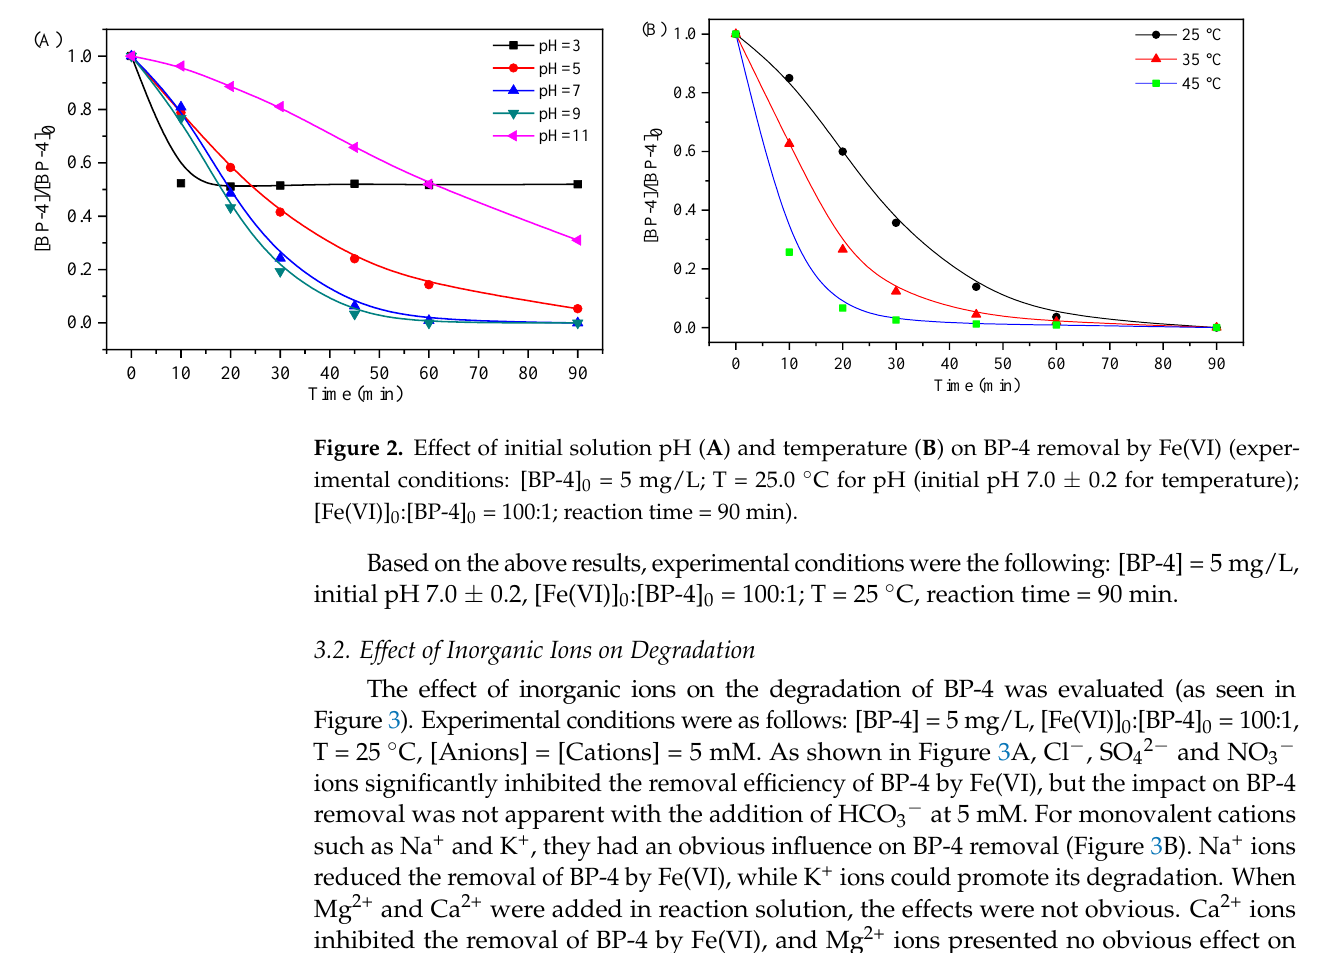
p H = 3 p H = 5 p H = 7 p H = 9